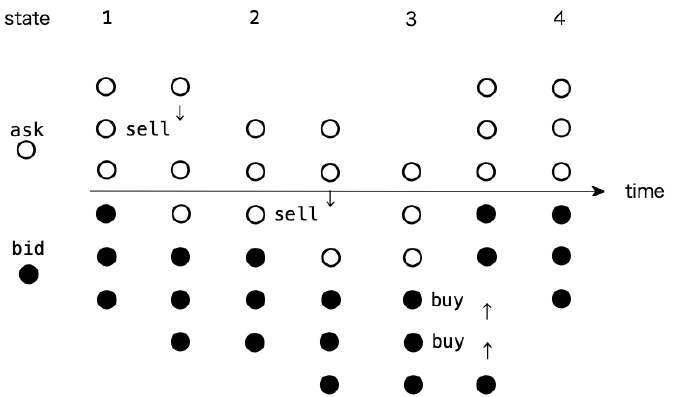
Figure 3. An image of simple security market model. First, in Market Equilibrium 1 in which trades are not made, the subjective equilibrium of a trader who indicates the second sales quote changes for some reason, and she sells to the trader with the highest buy quote. The buying trader then changes into a seller, and simultaneously, the selling trader changes into a buyer; then, they line up with their respective voluntary quotes. As the price is voluntary, they are aligned by the order of the quotes, and the subsequent Market Equilibrium 2 is realized and so